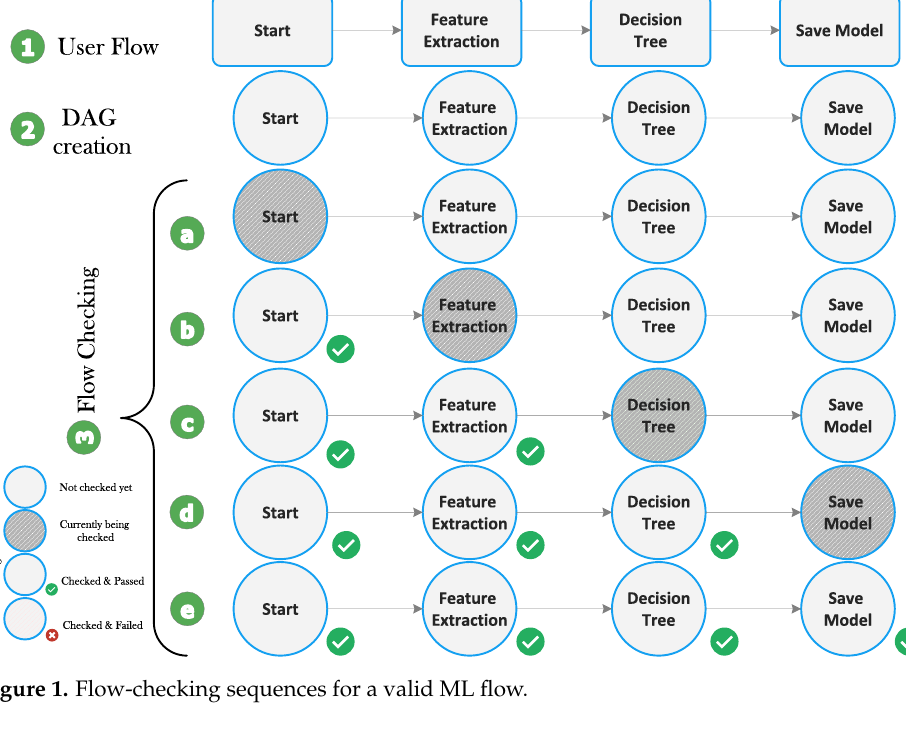
Figure 1. Flow-checking sequences for a valid ML flow.